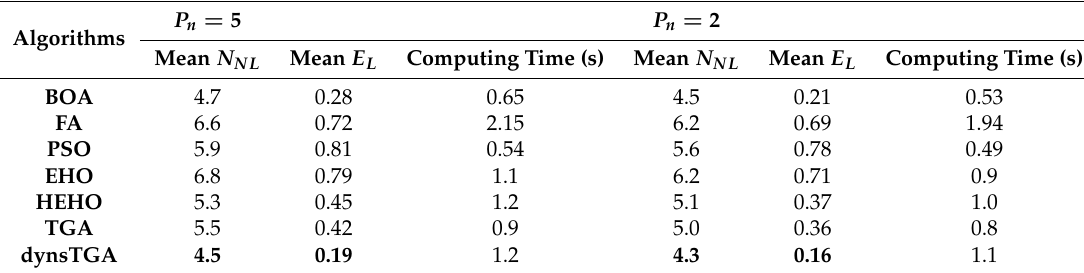
Table 6. Simulation results for M = 40, N = 8 and the search domain area 100 U × 100 U with different values for P n averaged in 30 runs—comparative analysis between butterfly optimization algorithm (BOA), firefly algorithm (FA), particle swarm optimization (PSO), EHO, HEHO, TGA, and dynsTGA (results for BOA, FA, and PSO were taken from [15]) (best results for each performance indicator are marked